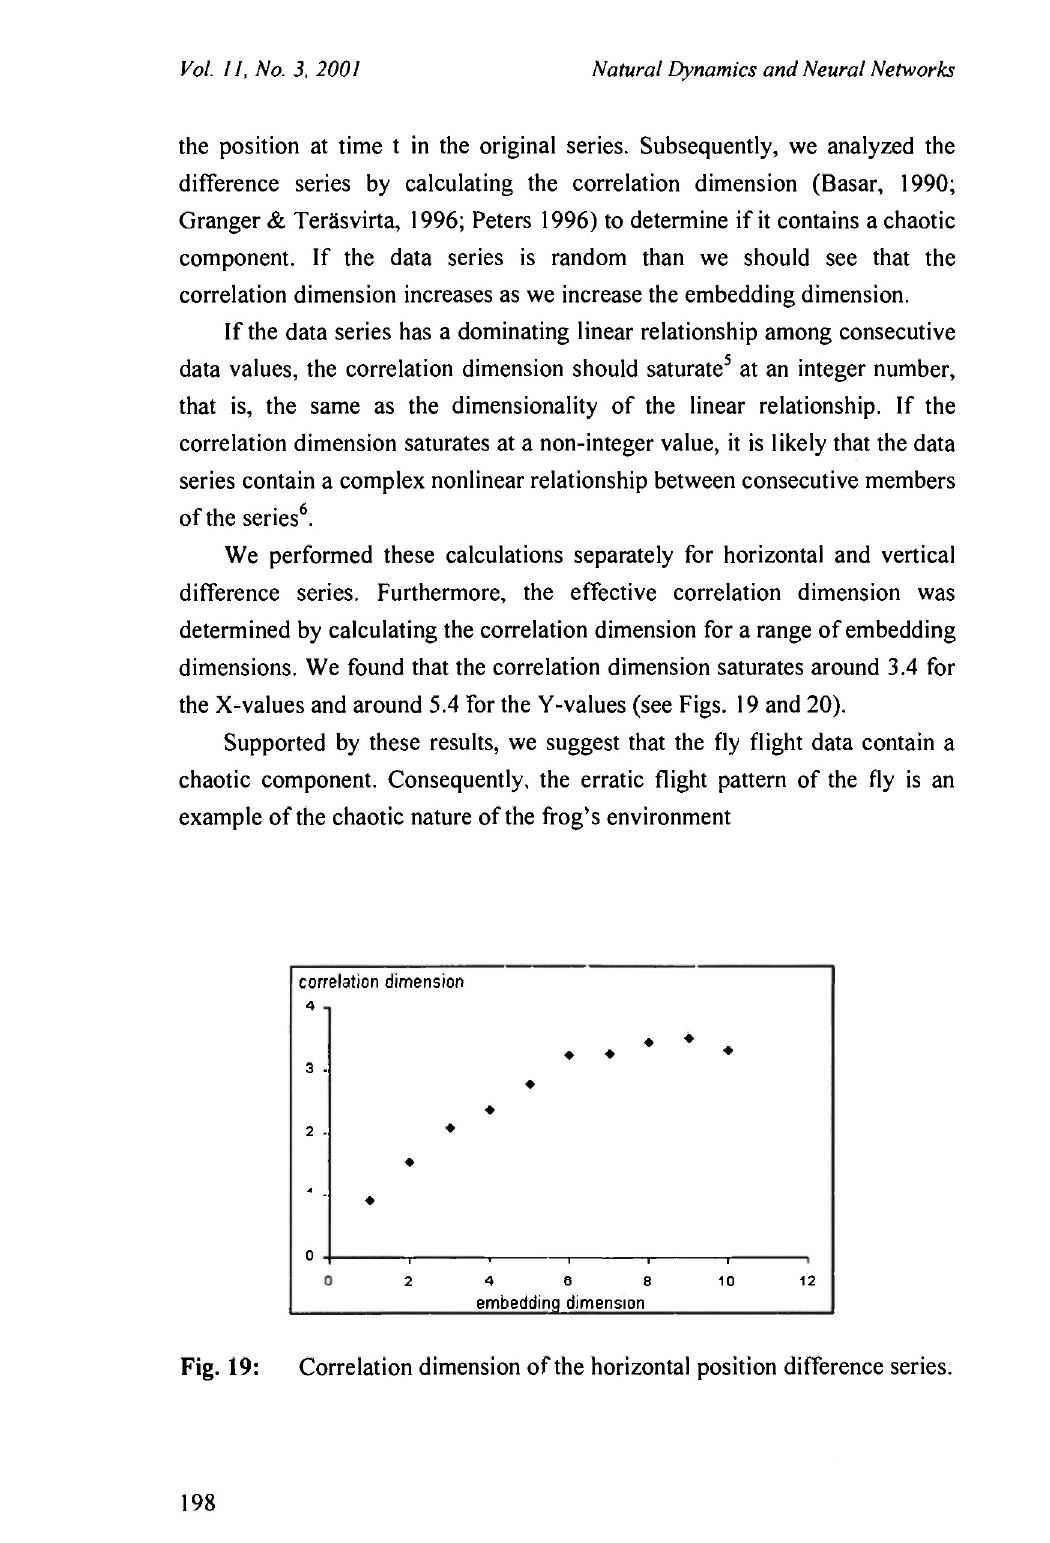
Fig. 19: Correlation dimension of the horizontal position difference